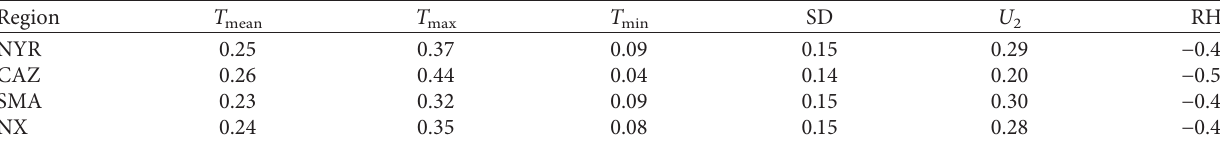
Figure 14: Wavelet analysis of each region at seasonal scale: (a) spring; (b) summer; (c) autumn; (d) winter. Table 7: Sensitive coefficient of the main climate factors to ET 0 from 1957 to 2018 in Ningxia at annual